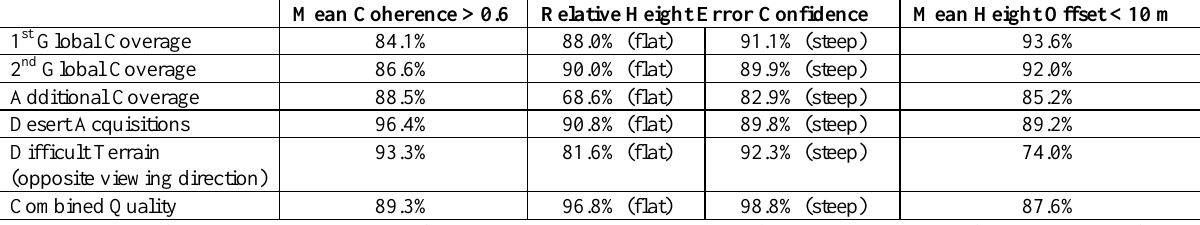
Table 2. Quality of over 458,000 DEM scenes from single coverages processed as of February 2015. 64% of these scenes are from the two global coverages. Percentages for coherence and absolute height offset are derived from the mean value per scene of all respective acquisitions. The relative height error analysis gives the confidence level for achieving the 2 m (flat) and 4 m (steep) specification. Relative height error data is based on quicklook map evaluation with a resolution of 300 m by 300